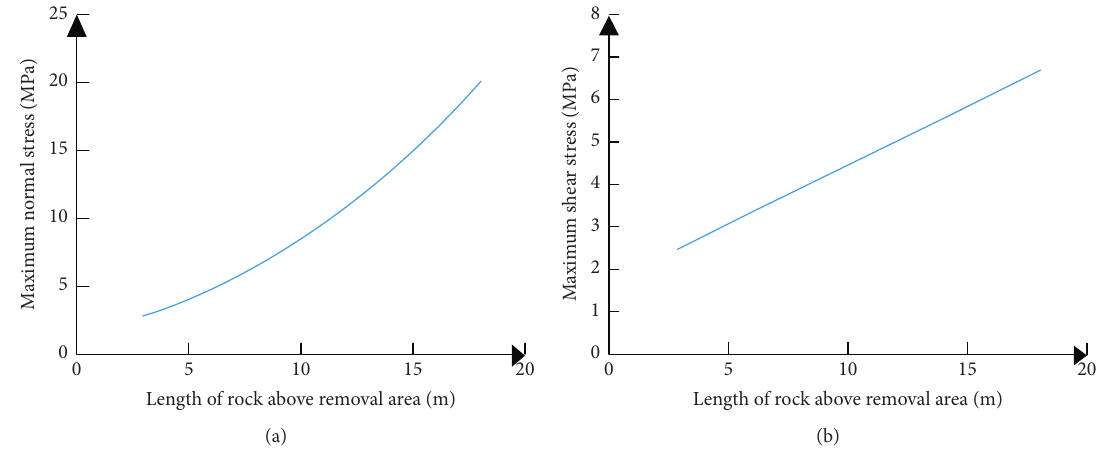
Figure 5: Internal stress of rock beam above the removal area. (a) σ